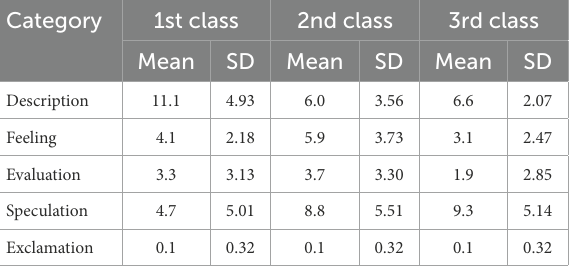
TABLE 3 Descriptive statistics for each kind of utterance made by novice actors in each Repetition